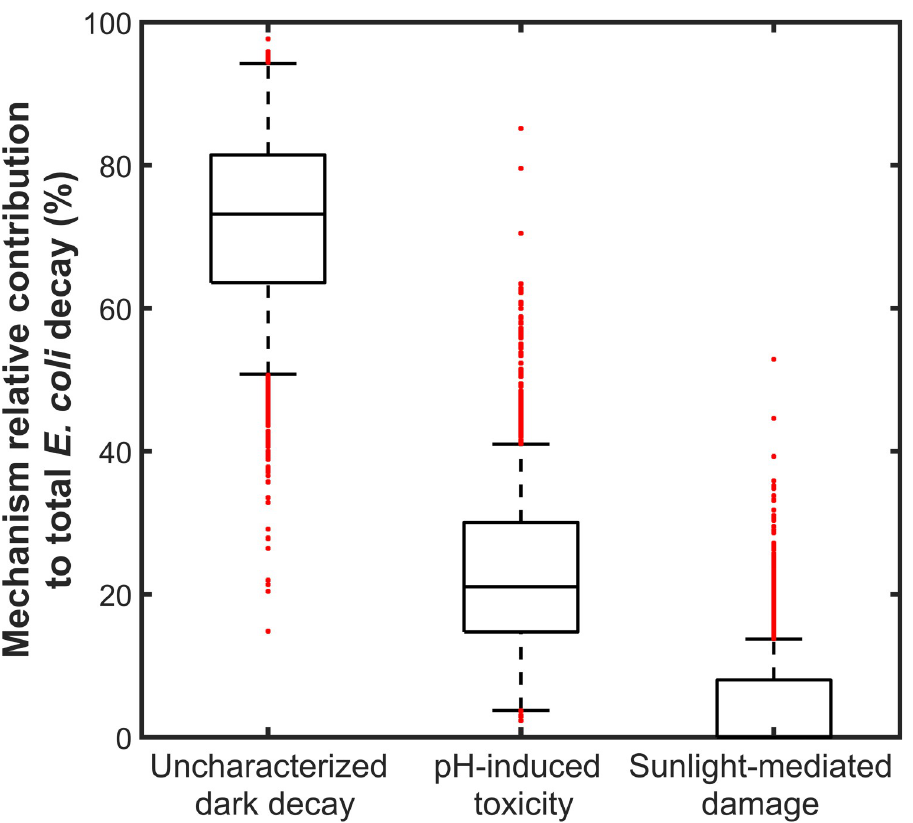
Fig 4. Relative contributions of removal mechanisms contributing to E . coli decay during bench assays. Boxplots represent the 5, 25, 50, 75, and 95 percentiles of the distributions, and red dots the outlying data (N = 1322).